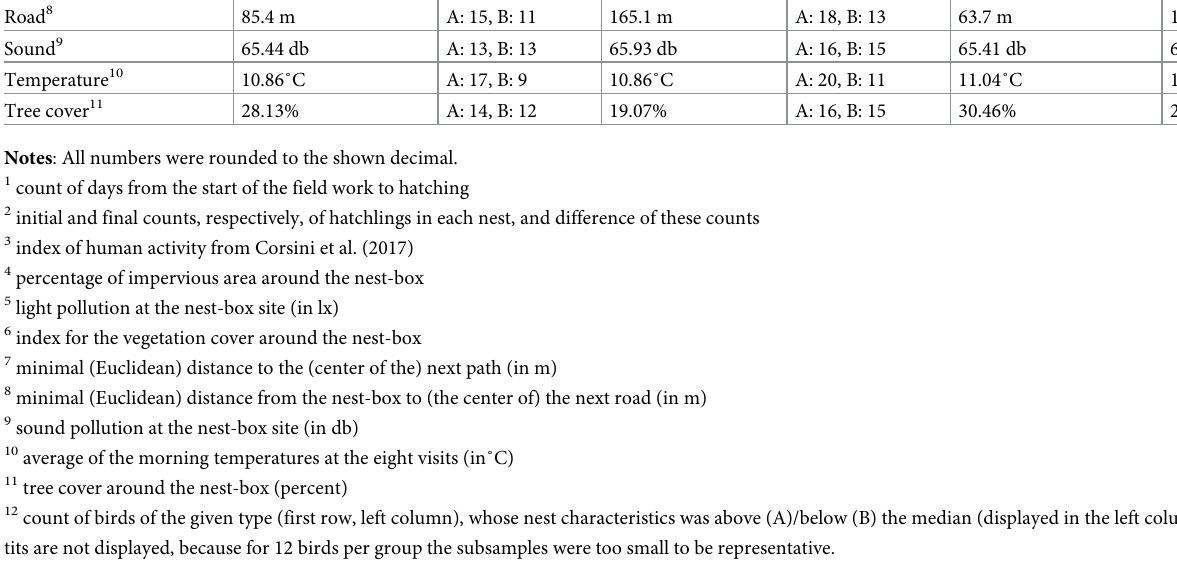
Notes : All numbers were rounded to the shown decimal. 1 count of days from the start of the field work to hatching 2 initial and final counts, respectively, of hatchlings in each nest, and difference of these counts 3